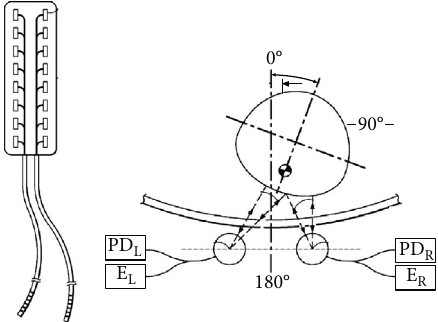
Figure 6: Construction and re fl ex measurement of spinal cord stimulation